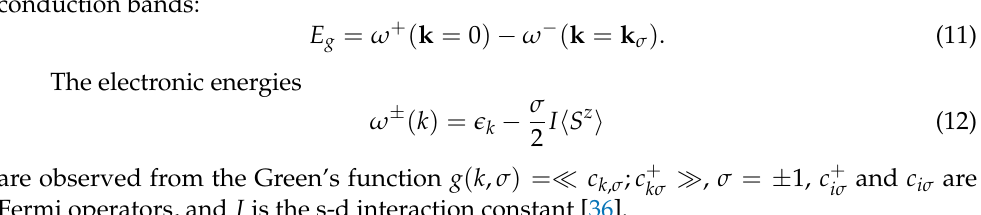
Figure 1: (Color online) Schematic presentation of the directions of the com- ponents of the Fe 3+ spins (black circle) and the position of the non-magnetic Y ions (blue circle) in the magnetic phase.